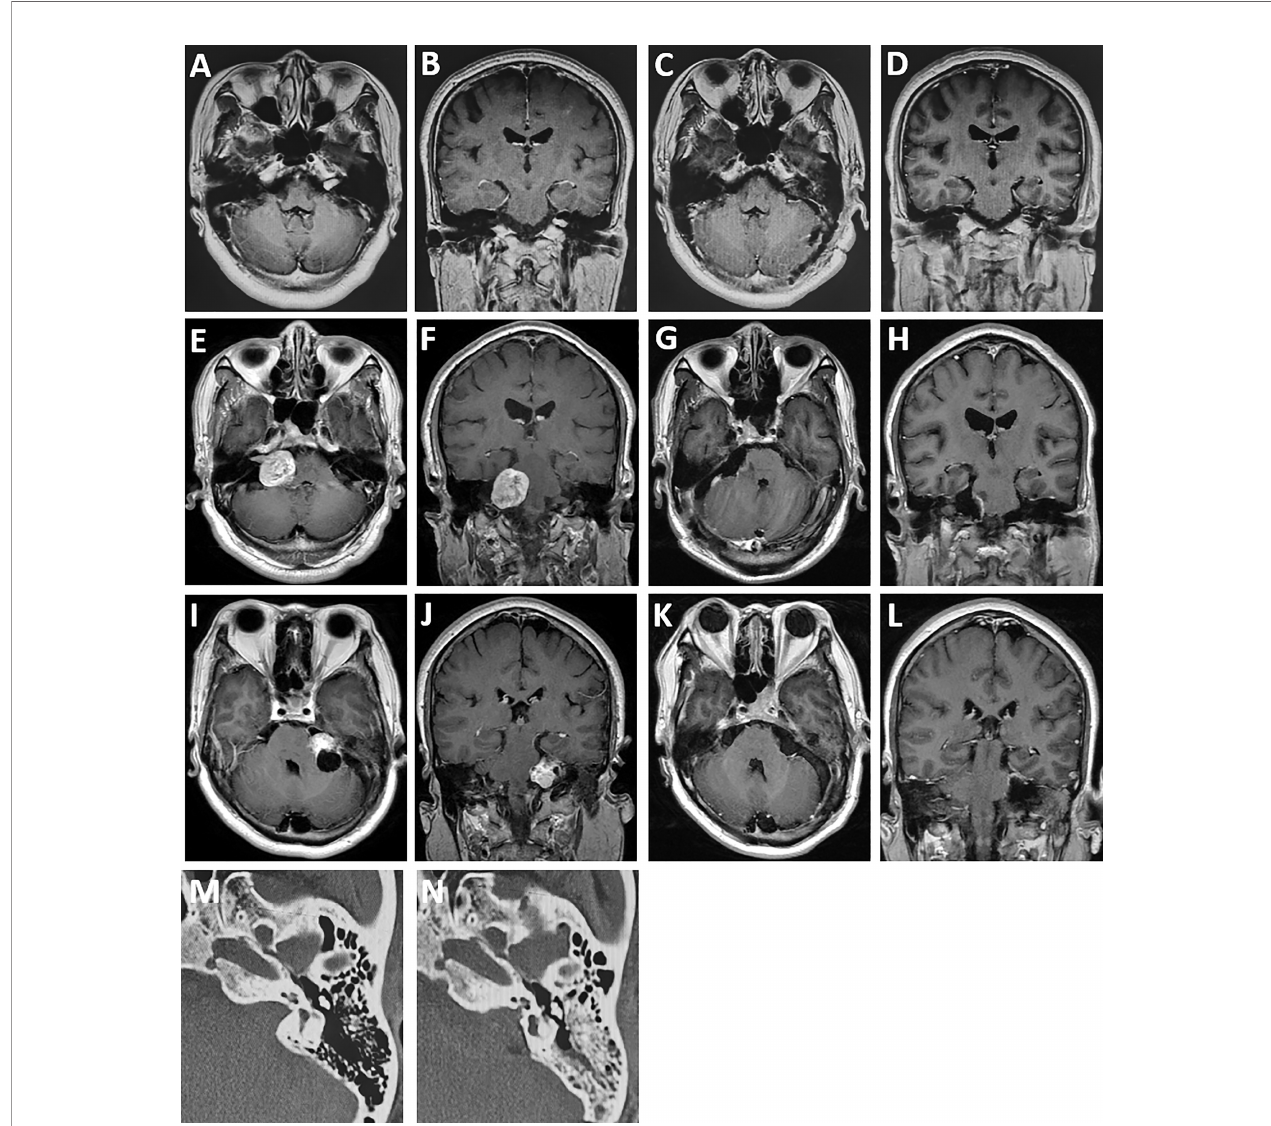
FIGURE 3 | Comparison of preoperative and postoperative MRI. (A, B) A patient with vestibular schwannoma in the internal auditory canal with effective hearing preoperatively. (C, D) MRI at 6-month follow-up revealing total tumor resection and hearing preservation obtained in the patient. (E, F) A patient with solid vestibular schwannoma in the cerebellopontine angle. (G, H) Baseline MRI at 6-month follow-up revealing gross total resection of the tumor and good facial nerve functional preservation (House – Brackmann grade I) after surgery. (I, J) A patient with predominantly cystic vestibular schwannoma with hearing loss before surgery. (K , L) MRI at 6-month follow-up showing no tumor recurrence. (M , N) Comparison of the bone window CT scans of the internal auditory canal before and after